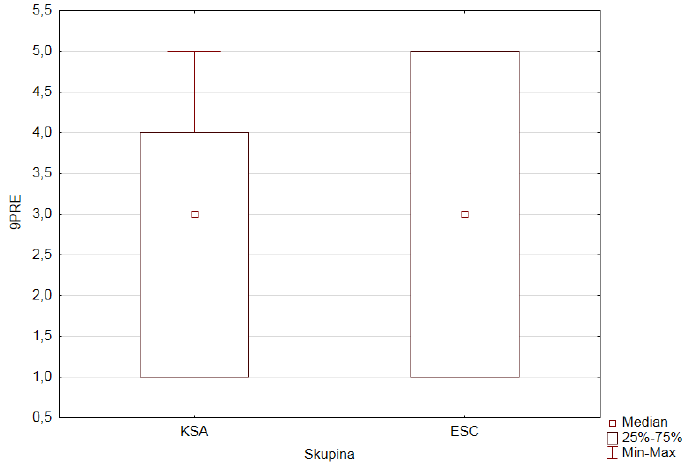
Figure 13. The box graph of the ninth item of the pretest - 9PRE.